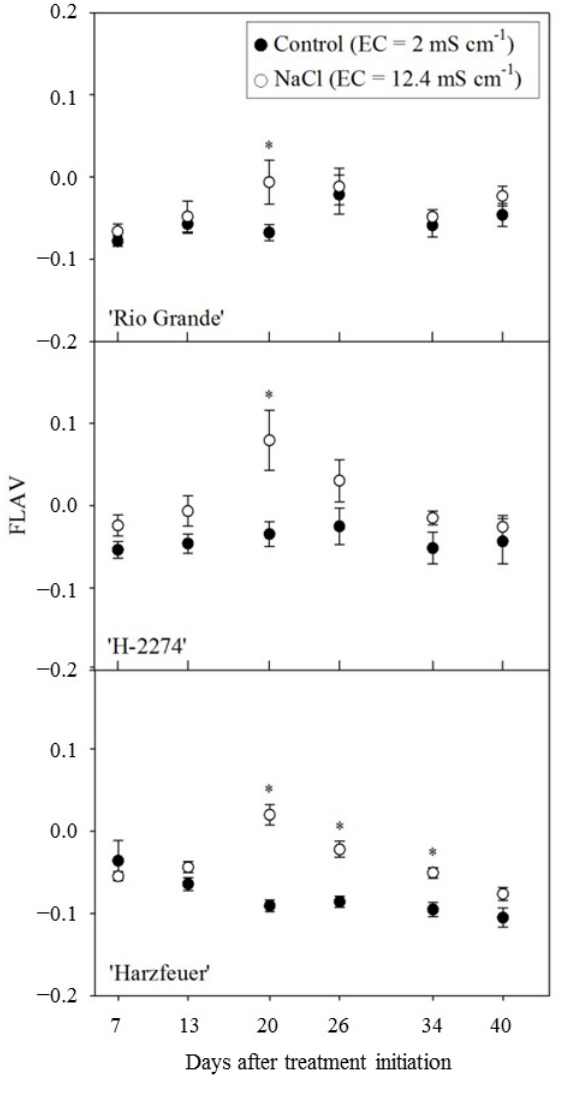
Figure 3. The FLAV-Index expressing the logarithm of the ratio of far-red fluorescence after red light excitation to far-red fluorescence after excitation with UV-light displayed over the time course of the experiment. Readings were taken on tomato leaves from the genotypes Rio Grande, H-2274 and Harzfeuer. Values represent the mean ± SE ( n = 10). * Significant differences ( p ≤ 0.05) between control and NaCl treatment for each genotype and measuring day, assessed by t